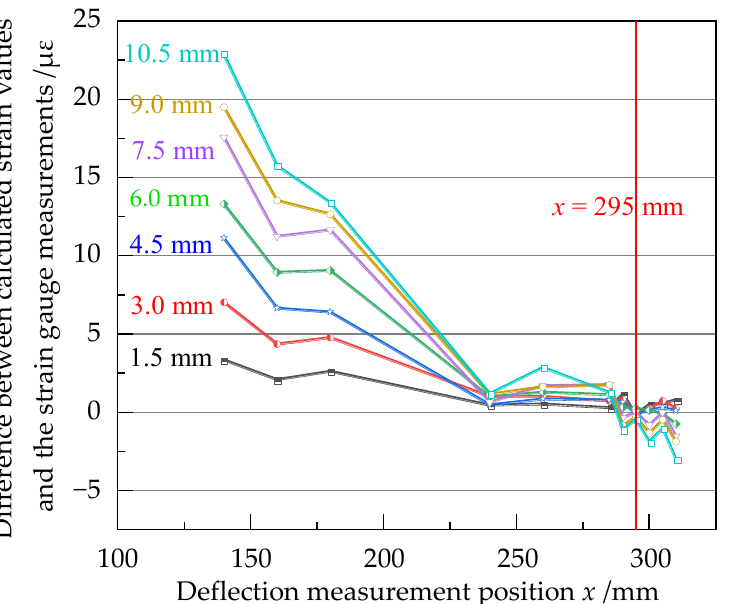
Figure 15. Difference between calculated strain values and the strain gauge measurements at the different deflection measurement positions under each loading step.